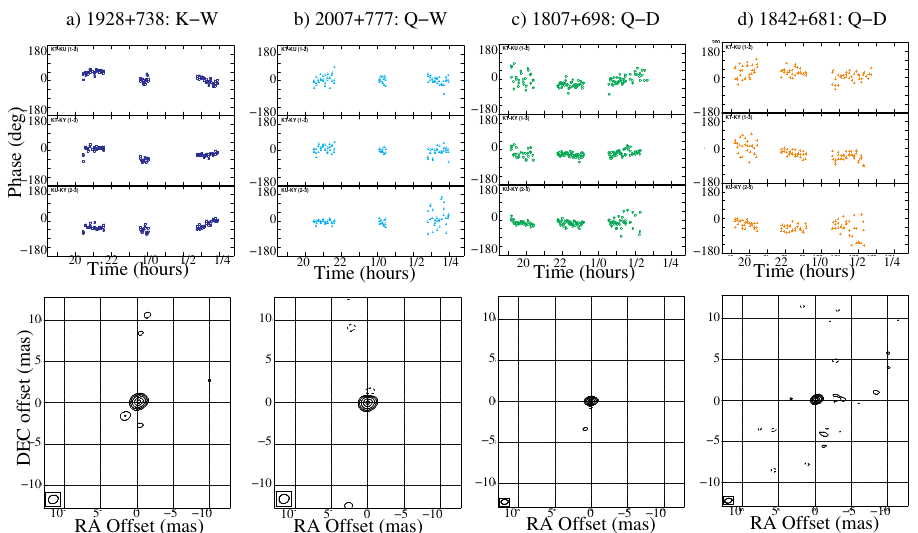
Figure 1. Outcomes of Source Frequency Phase Referencing (SFPR) astrometric analysis: Upper Row: SFPR-ed residual visibility phases for a subset of source and frequency pairs. The target source and target frequency band (i.e., ν high ), along with the angular separation to the reference source (in all cases 1803+784), the reference frequency band (i.e., ν low ) and the frequency ratio R, in parenthesis, are as follows for each plot. From left to right: 1928+738 at W-band (6.80 ◦ apart on the sky, K-band, R = 4); 2007+777 at W-band (6.3 ◦ apart, Q-band, R = 2); 1807+698 at D-band (8.6 ◦ apart, Q-band, R = 3); 1842+681 at D-band (10.7 ◦ apart, Q-band, R = 3). Lower Row: SFPR-ed maps resulting from Fourier transformation of the SFPR-ed visibility phases directly above. From left to right: 1928+738 and 2007+777 at 87 GHz (W-band); 1807+698 and 1842+681 at 130 GHz (D-band). Peak fluxes are 2 Jy · beam − 1 , 266 mJy · beam − 1 , 415 mJy · beam − 1 and 216 mJy · beam − 1 , respectively. The contour levels in the maps start from 0.75% of the corresponding peak fluxes, respectively, and doubling thereafter in all cases. Each map includes a negative contour level at the same percent level of the peak flux as the first positive one. The beam size is indicated at the bottom left of the image.